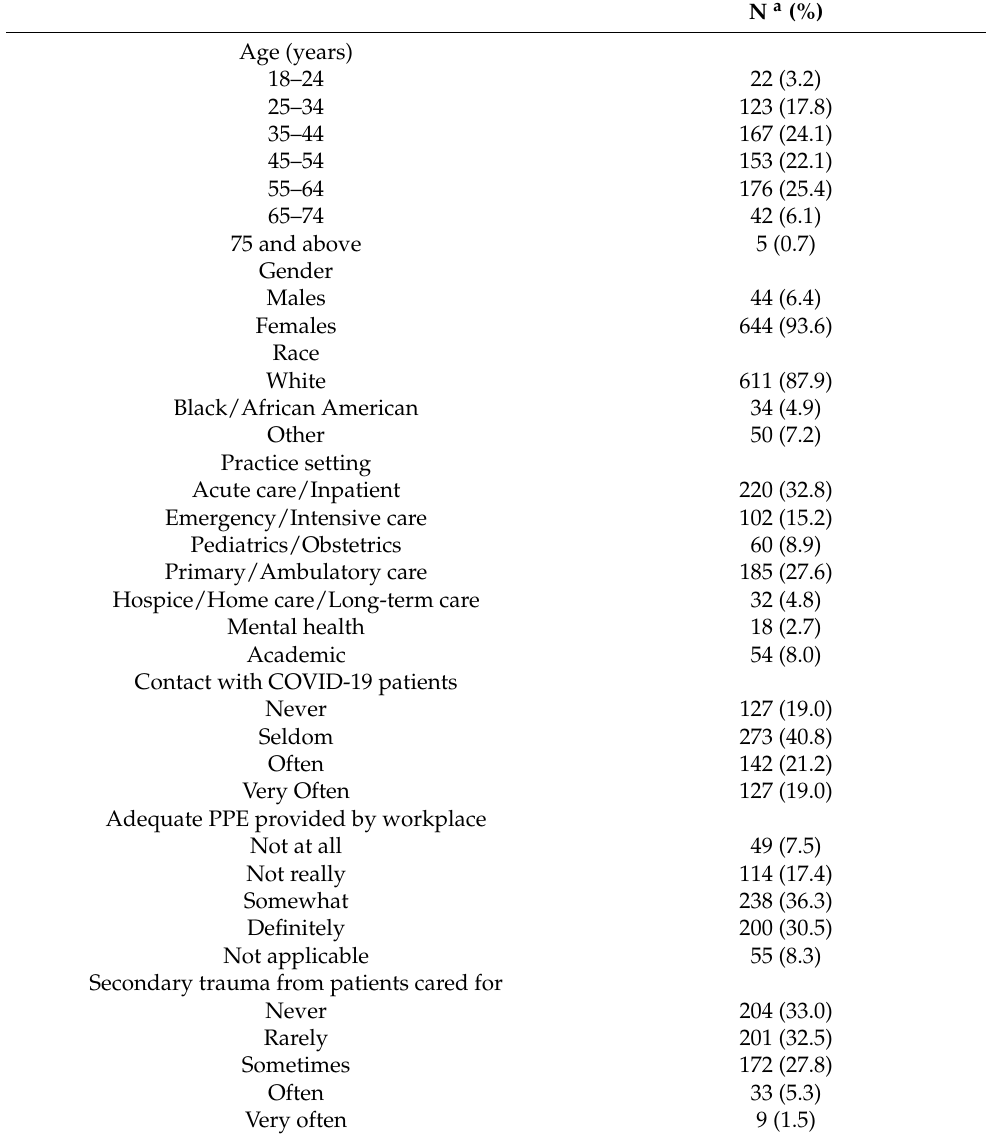
Table 1. Characteristics of study participants (n =